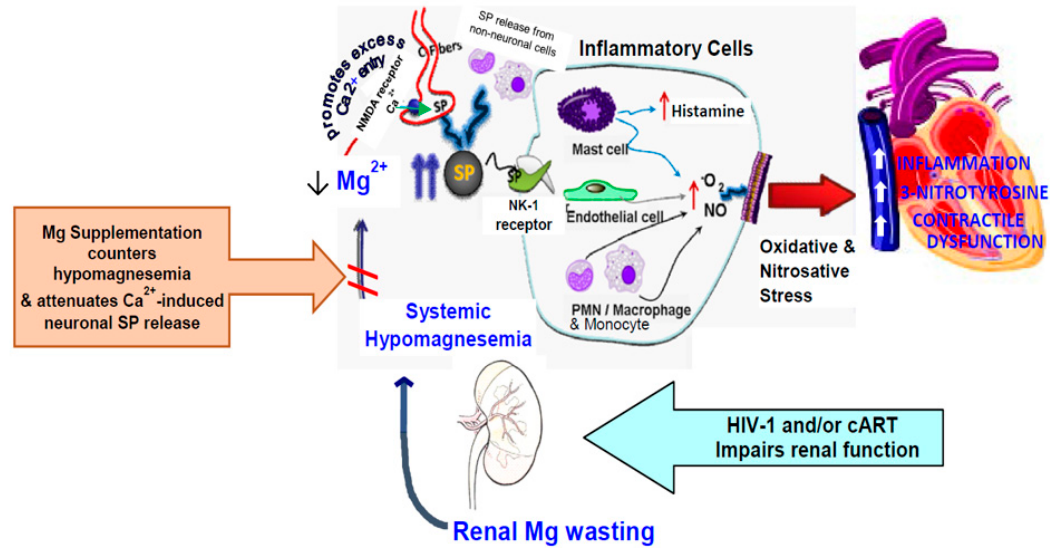
Figure 11. Chronic use of cART in HIV-1 infected patients may impair renal function, leading to magnesuria (Mg wasting) and hypomagnesemia-induced neurogenic (substance P [SP]) inflammation. Increased circulating SP levels, initially via activation of Mg-gated neuronal NMDA receptor (C-fibers), result in elevated inflammatory mediators (cytokines), ROS/RNS production, antioxidant depletion, and further kidney, and cardiac pathology/dysfunction. We suggest that chronic oxidative/nitrosative stress associated with prolonged hypomagnesemia may amplify and/or sustain SP-mediated injury. Mg supplementation may lessen the hypomagnesemic-inducing effects caused by cART in HIV patients, and should reduce the risk of kidney, and cardiac toxicity/dysfunction by limiting SP bioavailability.